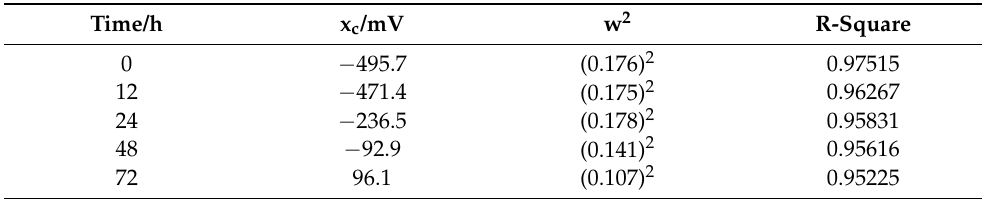
Table 3. Surface SKP Potential Gaussian Fitting of Super 13Cr Tubing after Different Times of Soaking in the CO 2 -Saturated Formate